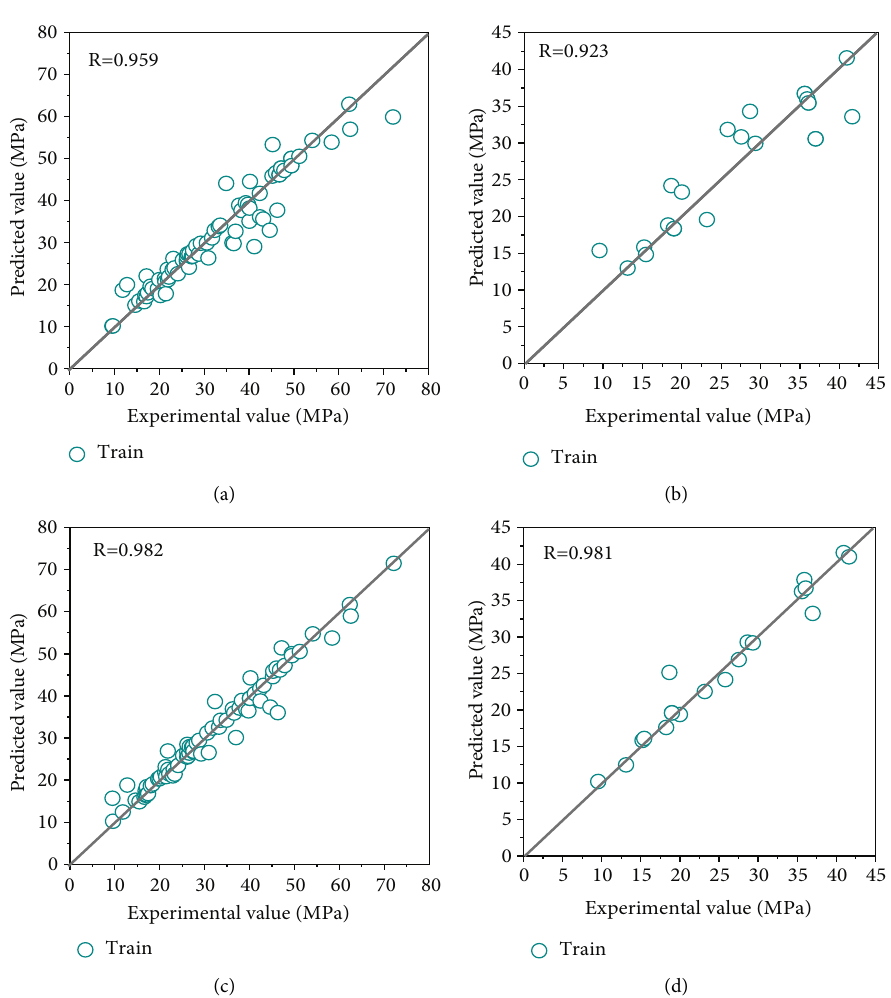
Figure 6: Correlation between predicted and experimental values of two models. (a) SVR model. (b) GS-SVR